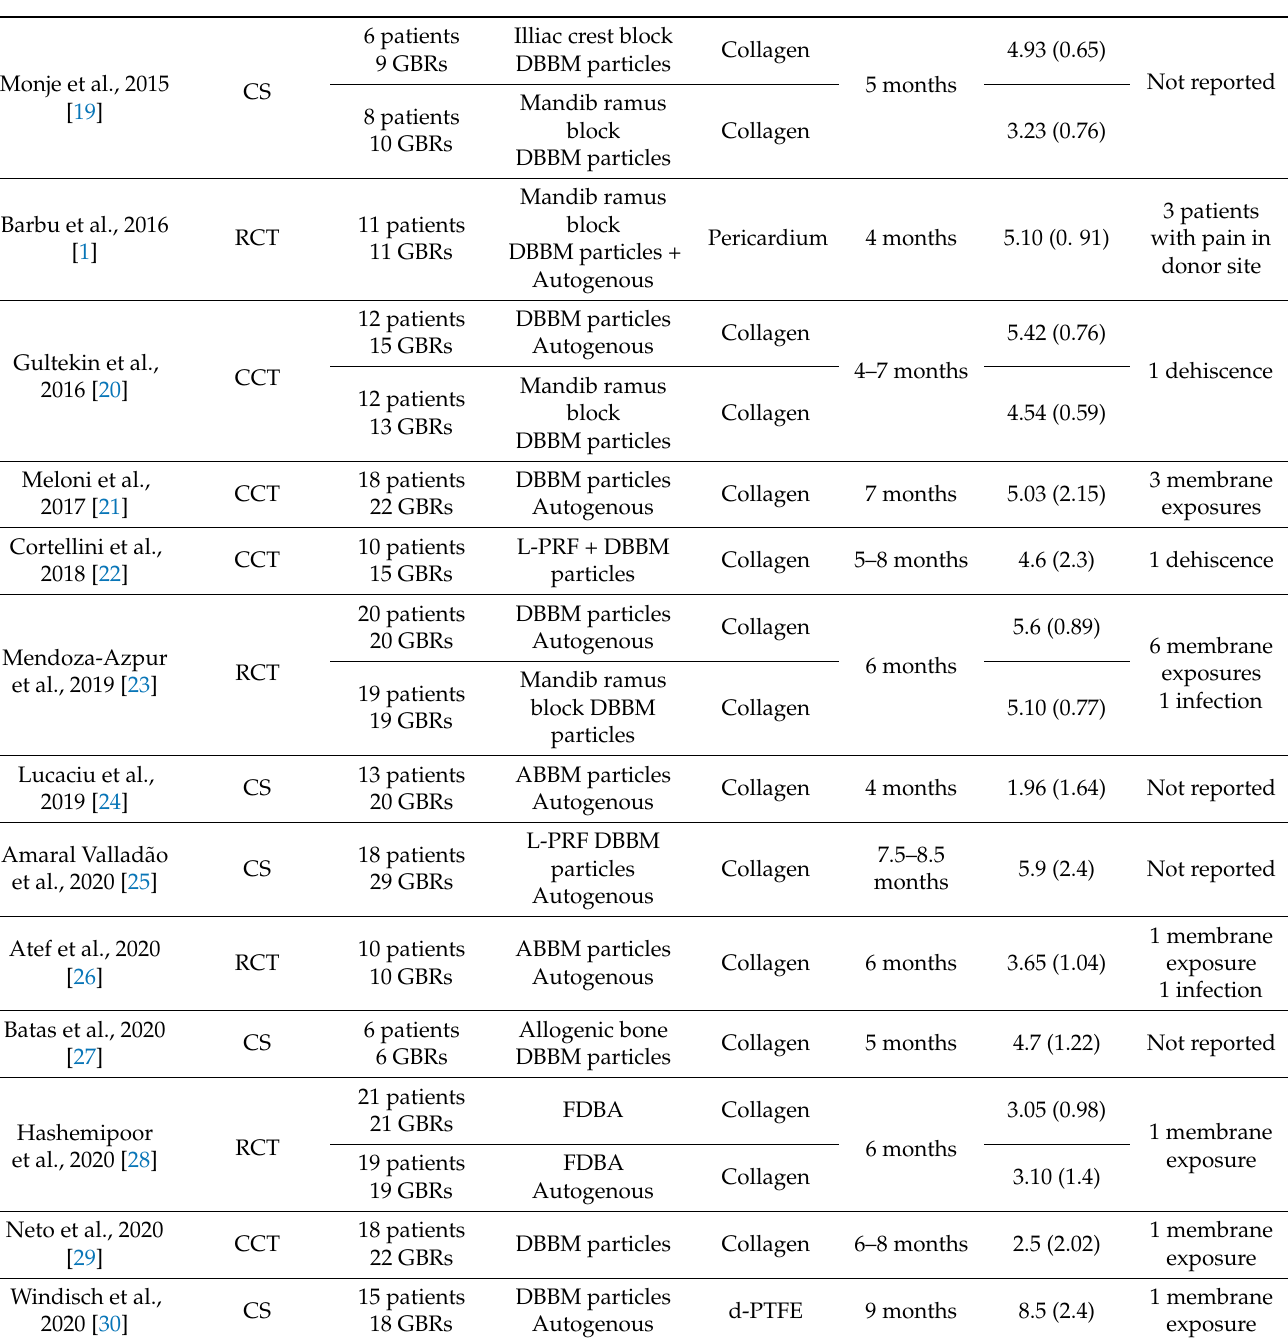
Figure 2. Most of the selected studies are classified as high quality or low risk of